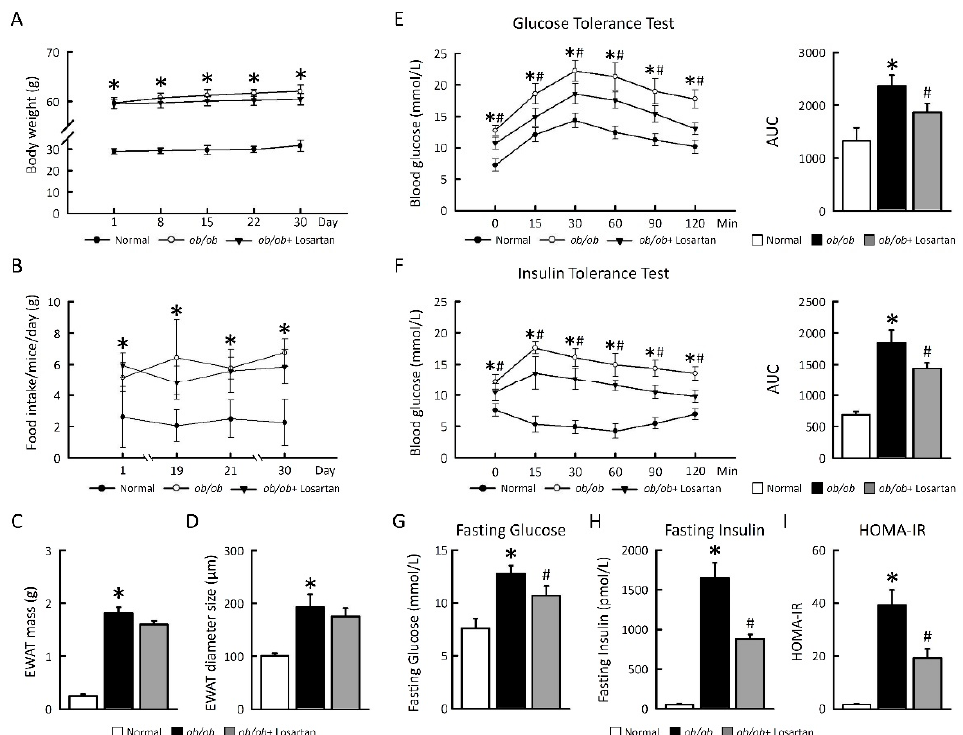
Figure 1. Losartan improved insulin sensitivity in EWAT. ( A ) 30-day Body weight change. ( B ) Food intake. ( C ) EWAT mass. ( D ) EWAT diameter size. ( E ) GTT ( F ) ITT. ( G ) Fasting glucose. ( H ) Fasting insulin. ( I ) HOMA-IR. Right graphs indicate quantification relative to AUC. For each animal group, n = 5. All values represent the mean ± SEM. Data were analyzed by Student’s t test. * p ≤ 0.05, normal vs. ob/ob ; # p ≤ 0.05, ob/ob vs. ob/ob + Losartan. HIF1 α : hypoxia-inducible factor 1 α ; EWAT: epididymal white adipose tissue; GTT: glucose tolerance test; ITT: insulin tolerance test; HOMA-IR: homeostasis model assessment of insulin